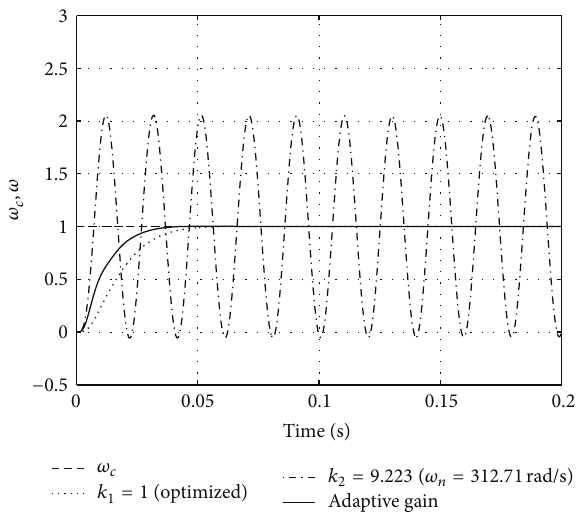
Figure 20: Time responses of position control system for 𝐾 1 = 1 , = 7.877 , and adaptive 𝐾 2